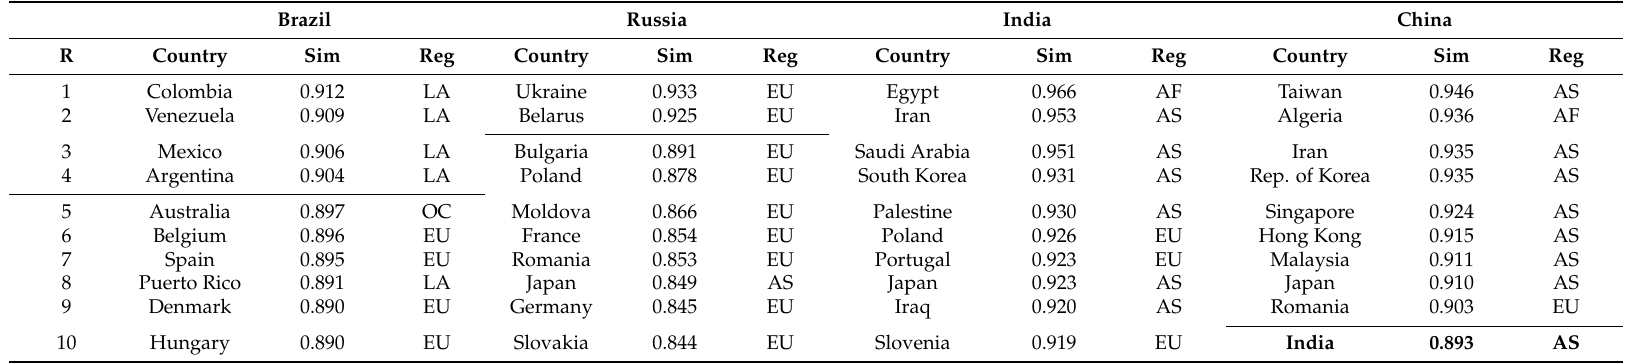
Table 3. Top 10 similar countries for each BRIC country. Regions (Reg): North America (NA), Latin America (LA), Africa (AF), Asia (AS), Oceania (OC) and Europe (EU).